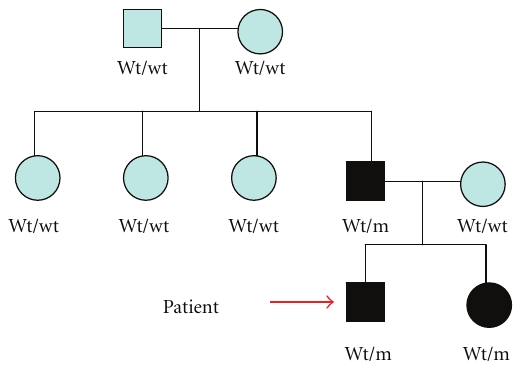
Figure 1: Squares represent male family members, and circles rep- resent female members. Wt = wildtype, Wt/m = wildtype/mutant. Solid squares and circles represent persons with diabetes carrying the C95Y